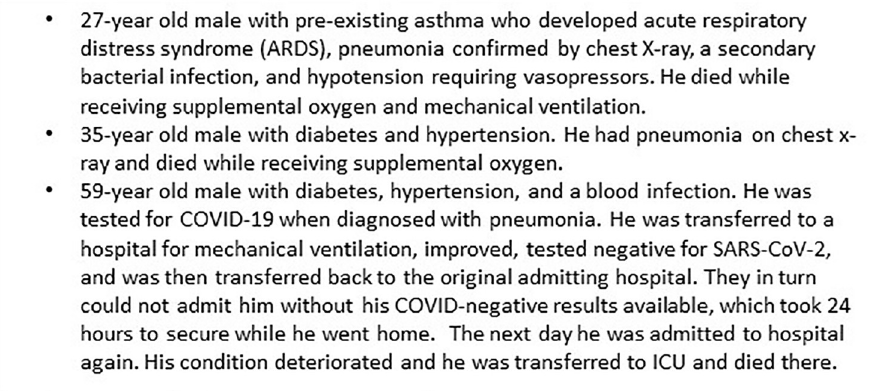
Fig 3. Summary of COVID-19 deaths in Kisumu, FFX Study, Kenya, June-October 2020.